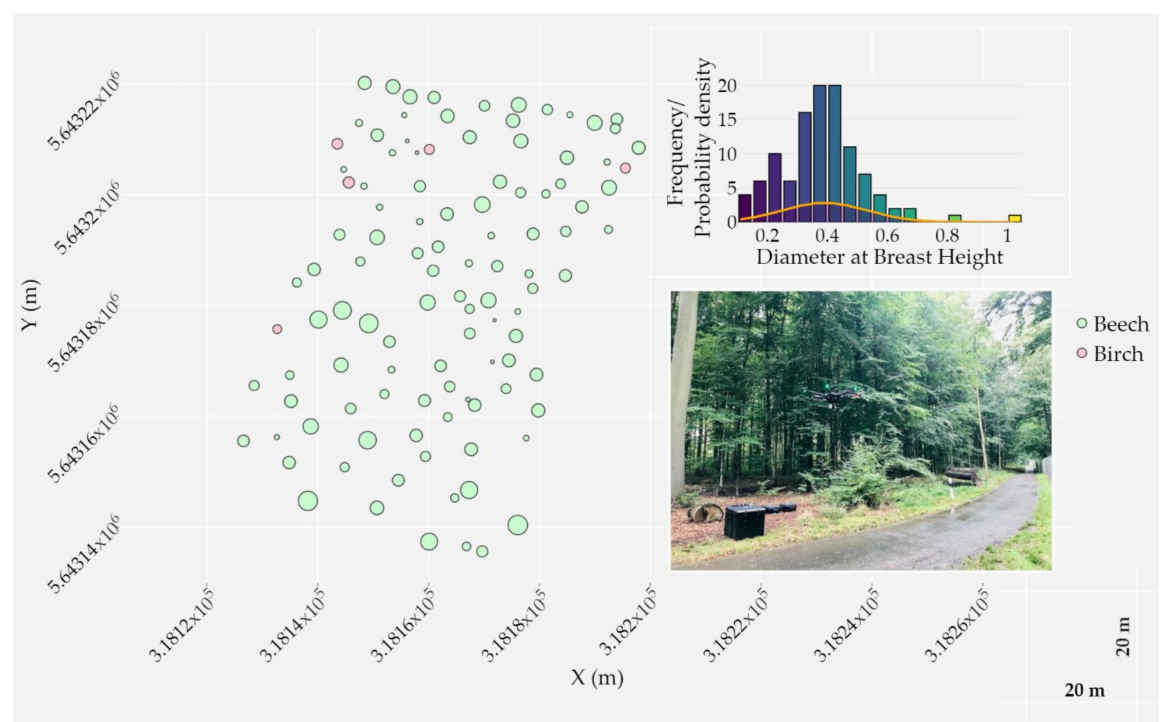
Figure 2. Spatial distribution of surveyed trees inside the main study area; two trees are not visualized for the sake of visibility. Trees are classified by species and the Diameter at Breast Height (DBH) is displayed using a proportional circle marker. Cartesian coordinates are expressed in UTM 32N. A histogram of DBH frequency for both species along with a probability density distribution are shown (top right). A photograph of the plot is shown on the bottom right; the study area is located across the road in a temperate deciduous closed-canopy forest